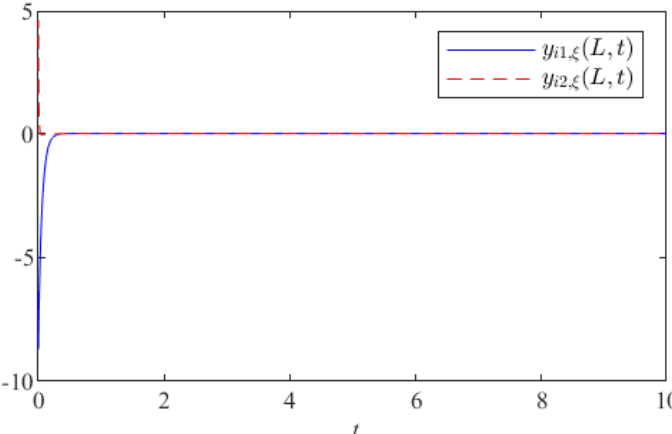
Figure 8. The boundary coupling y i ( L , t ) in Example